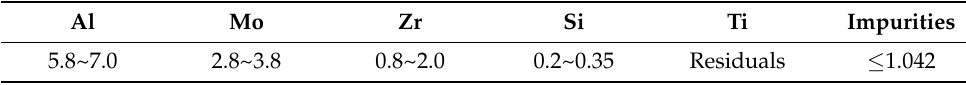
Figure 1. ( a ) Schematic diagram of WAAM technology [26]; ( b ) WAAM equipment. Table 1. Specific chemical composition of TC11 titanium alloy